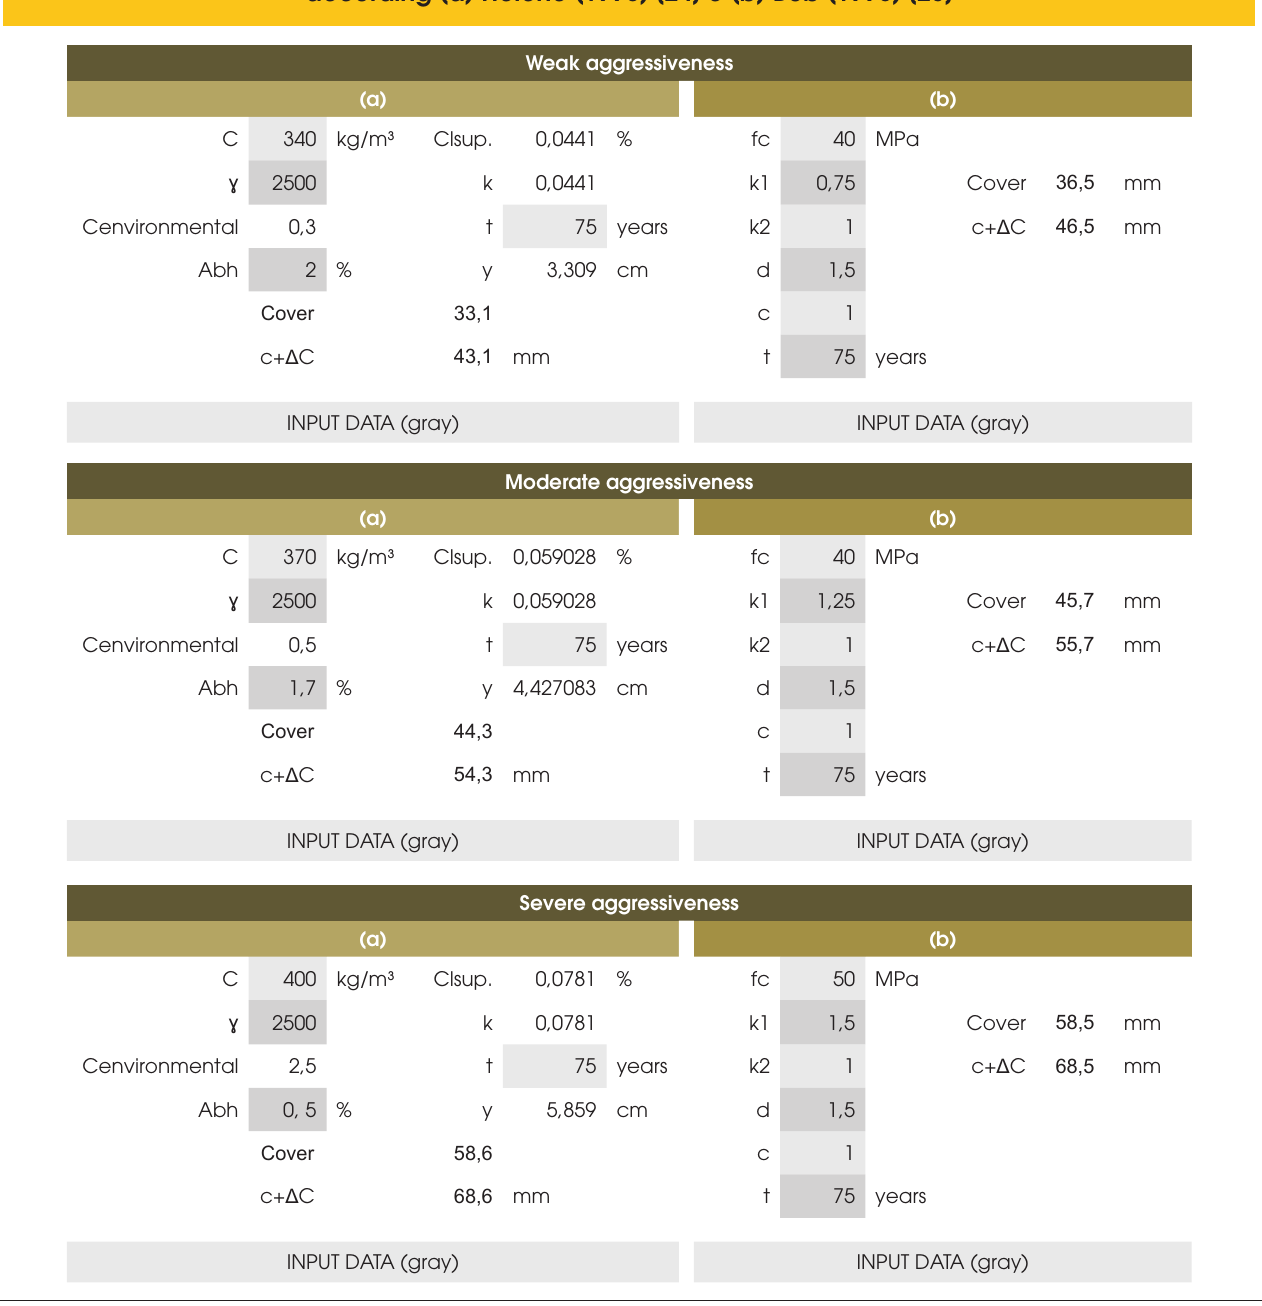
Table 13 – Service life prediction model for elements subjected to severe aggression by